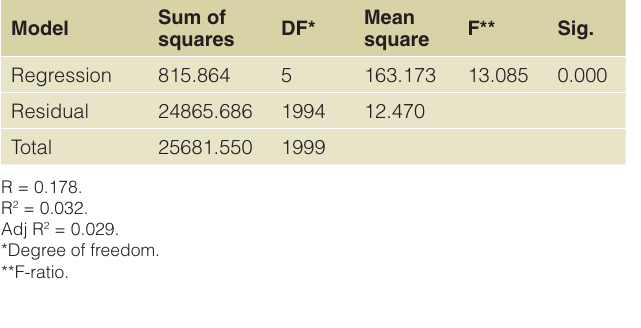
Table 14. Relative contribution of independent variables (age, gender, religion, ethnicity and parent’s occupation) to perspective on abstinence-only sexual education.